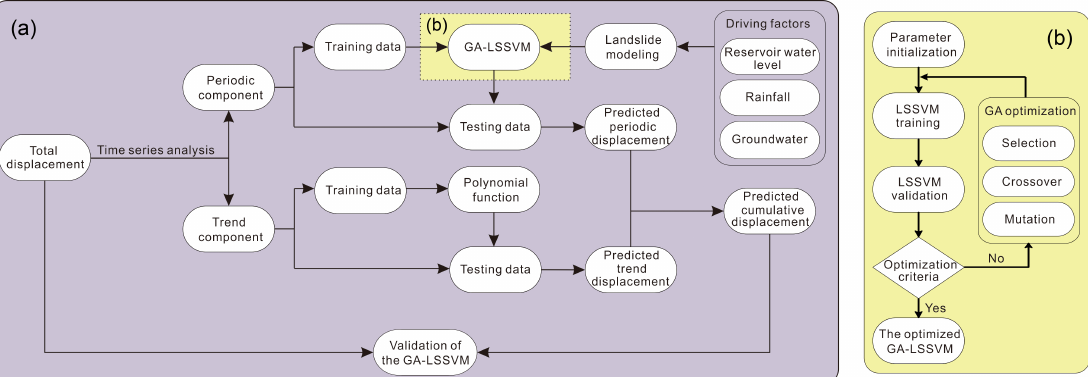
Figure 2. The basic flowchart of the GA-LSSVM model, including the validation of the model and the establishment of the GA-LSSVM model.